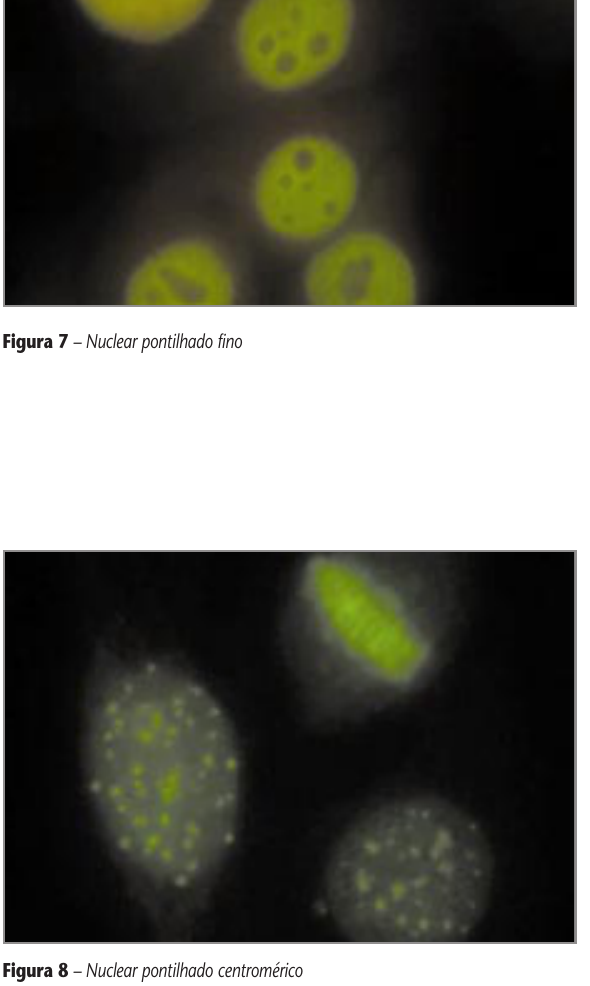
Figura 11 – Nucleolar